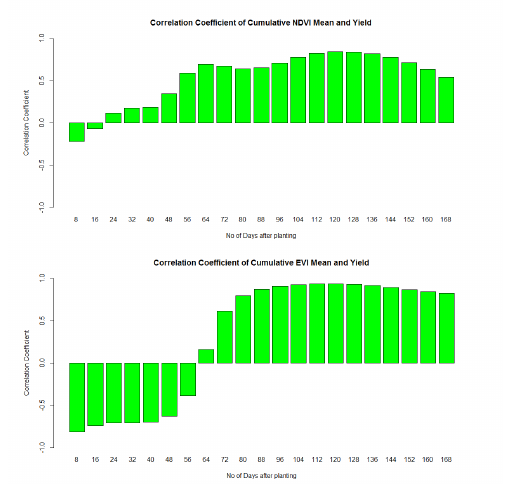
Figure 12: Correlation coefficient changing graph of the Cumu- lative VI mean and yield)